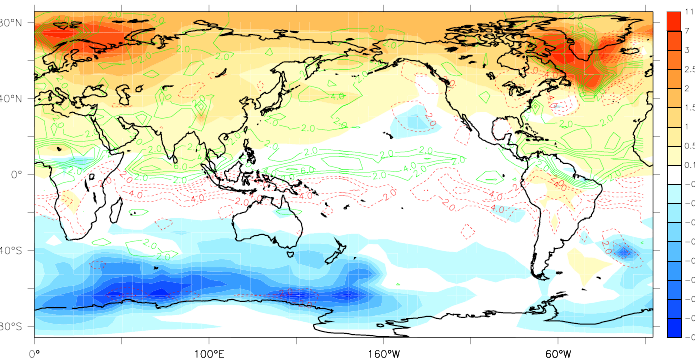
Fig. 8. SAT difference in K (shaded) and precipitation difference in cm/yr (contours) between a strong and a weak AMOC state for the OBL22.1 run. A weak (strong) state is defined by an AMOC < 21Sv ( > 27Sv). See also Fig. 2i. Note the non-linear color scale for SAT difference.